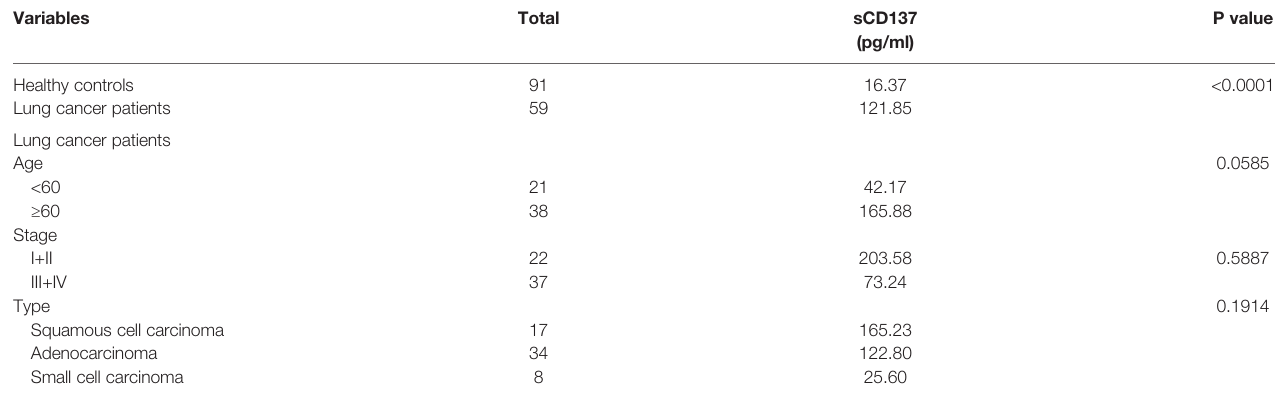
TABLE 1 | Correlations between blood sCD137 levels and clinical characteristics in untreated patients.